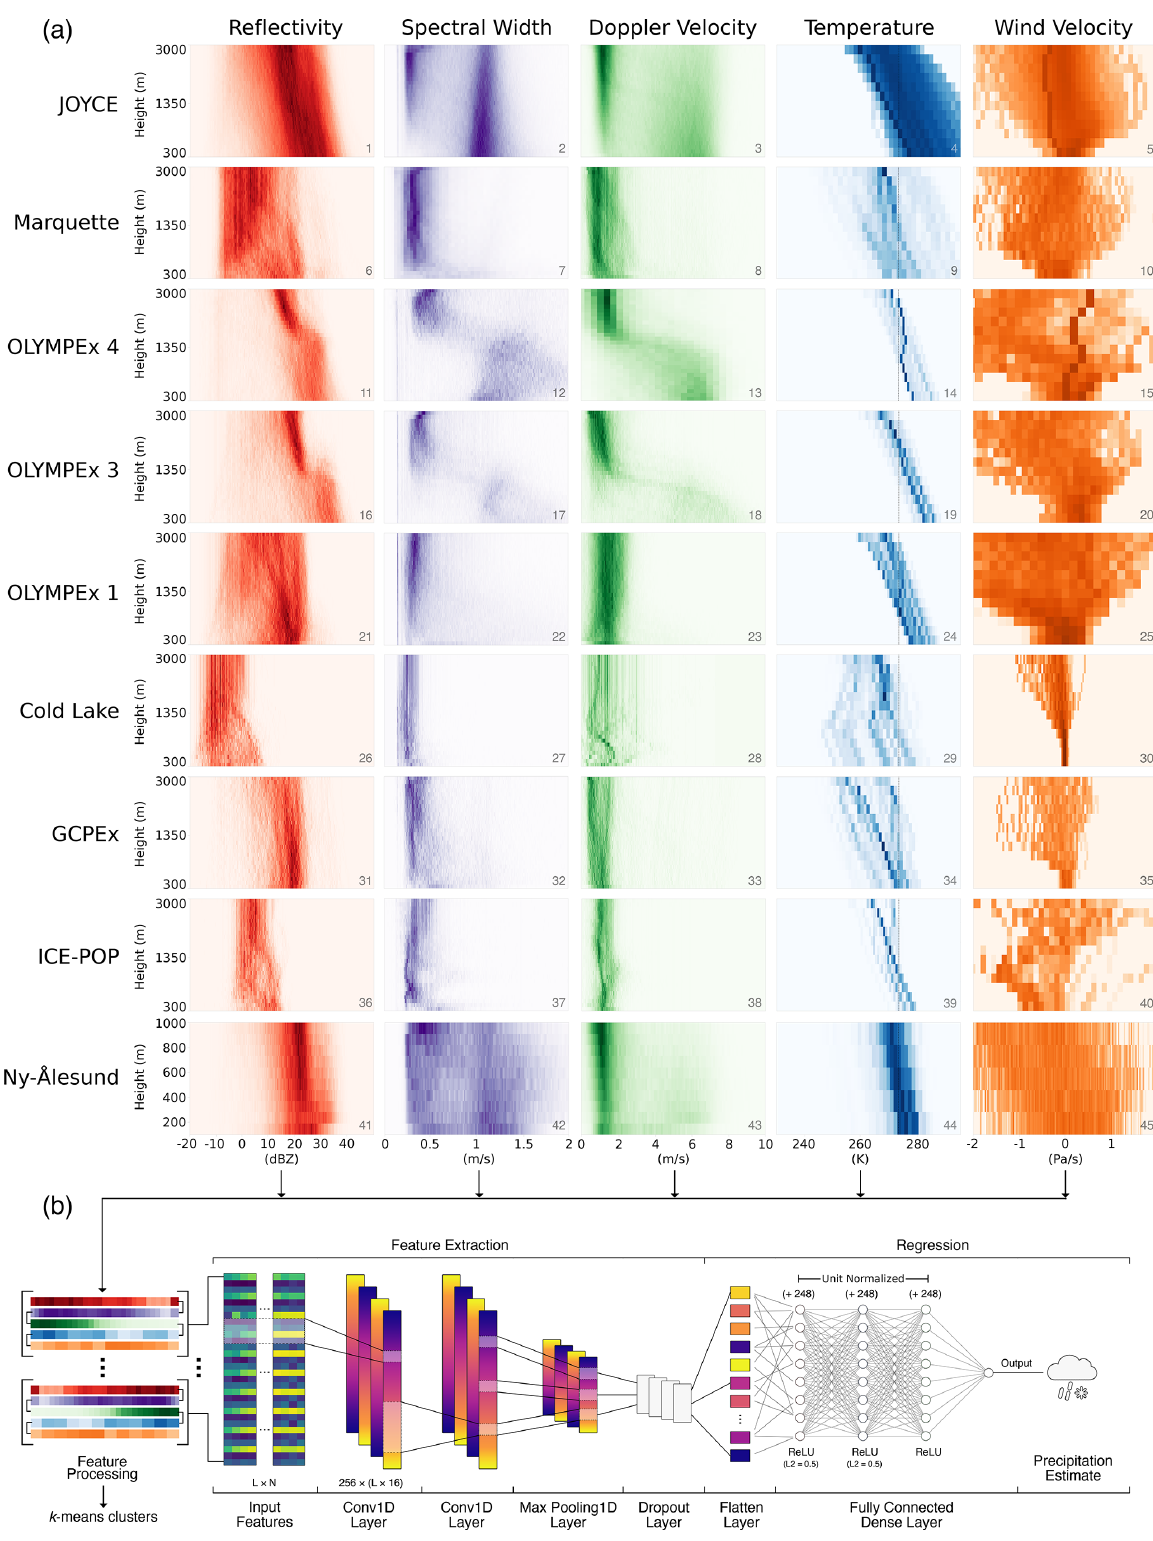
Figure 2. DeepPrecip input covariates, feature processing pipeline, and model architecture. (a) Site-predictor matrix of normalized Micro Rain Radar (MRR) and ERA5 observational frequency histograms used in model training and testing. Note that darker colors in the 2D heatmaps indicate a higher frequency of observations. (b) DeepPrecip convolutional neural network diagram for L inputs with N predictors.